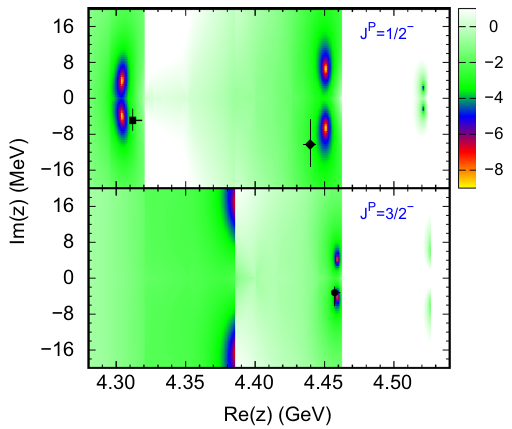
Fig. 3 Thelog | 1 − V ( z ) G ( z ) | withthevariationof z forthe Σ ( ∗ ) c ¯ D ( ∗ ) − ¯ D ( ∗ ) interaction with J P = 1 / 2 − and 3 / 2 − at α = 2 . 5. The color Λ c means the value of log | 1 − V ( z ) G ( z ) | as shown in the color box. The form factor f 3 is adopted in the calculation. The full square, diamond, and circle are for the experimental data of the P c ( 4312 ) , P c ( 4440 ) and P c ( 4457 ) at LHCb